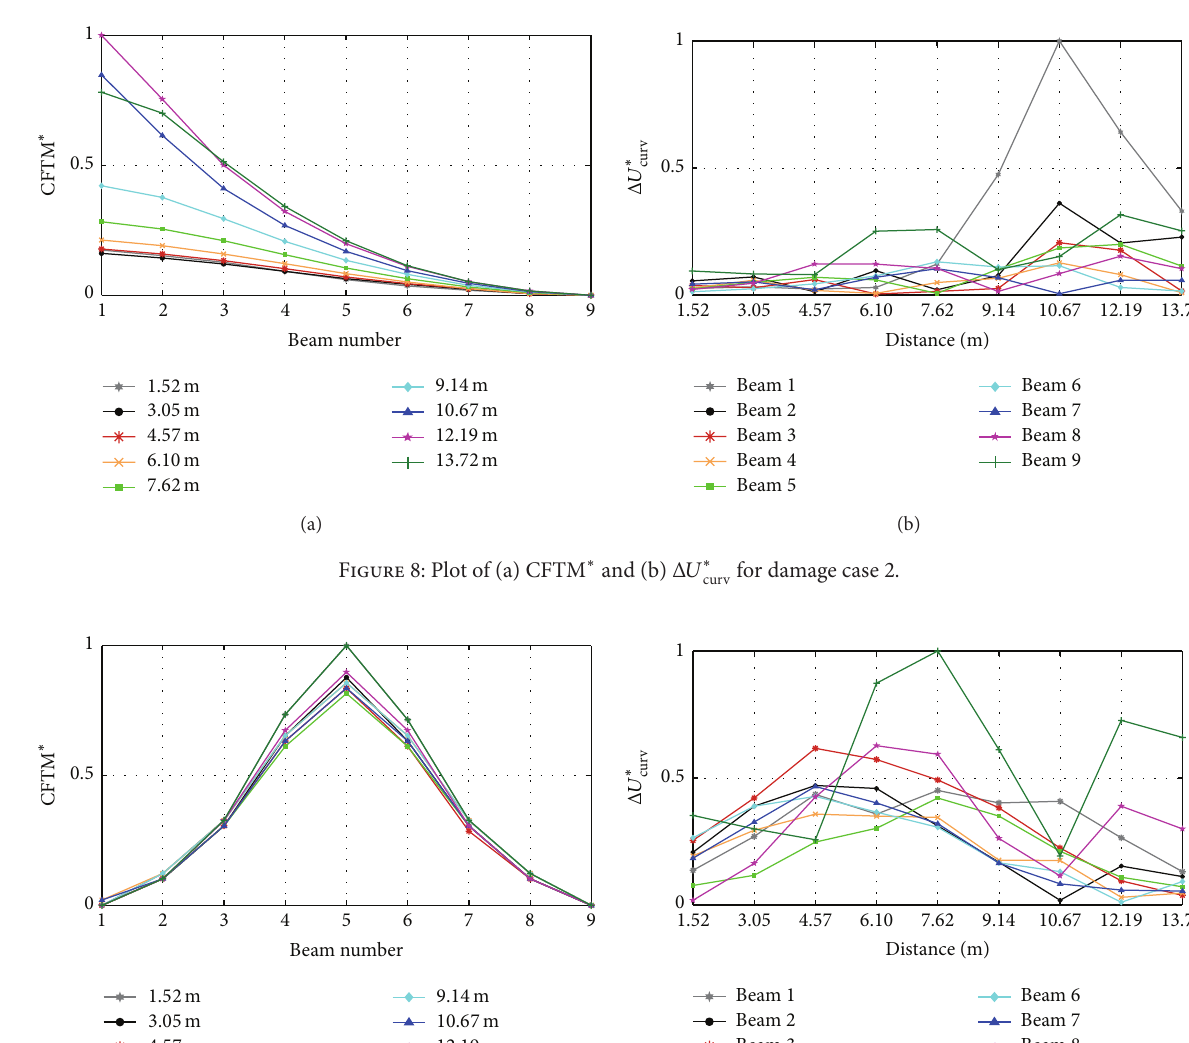
Figure 9: Plot of (a) CFTM ∗ and (b) Δ𝑈 ∗